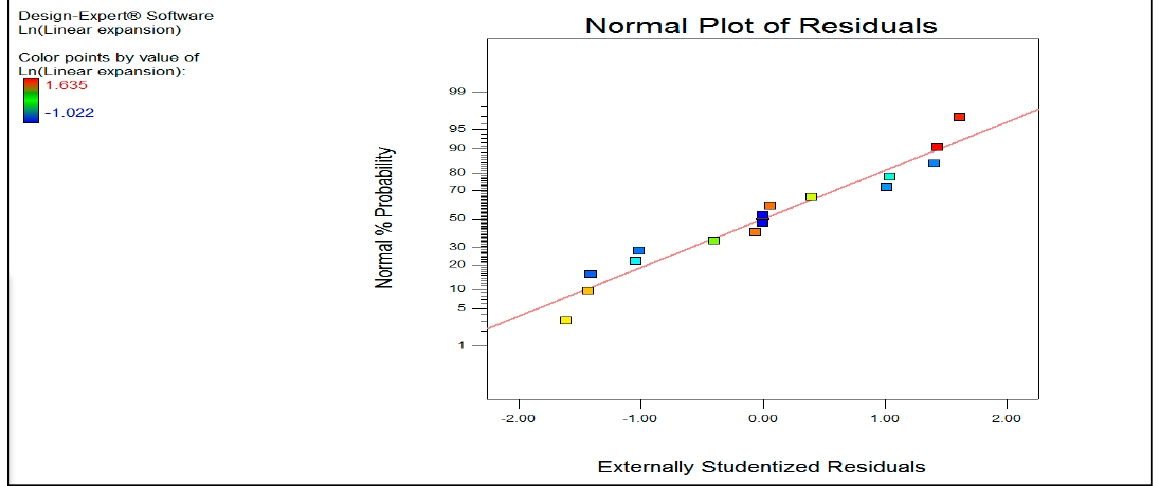
Figure 8. Normal plot of residual.